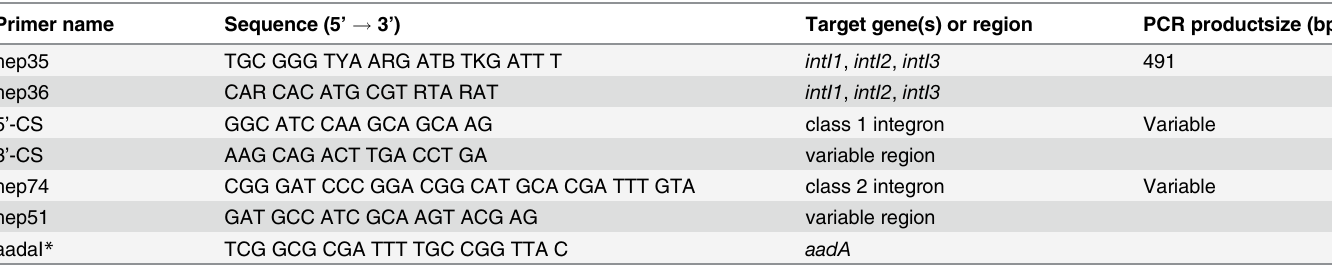
Table 1. Primers used in the PCR